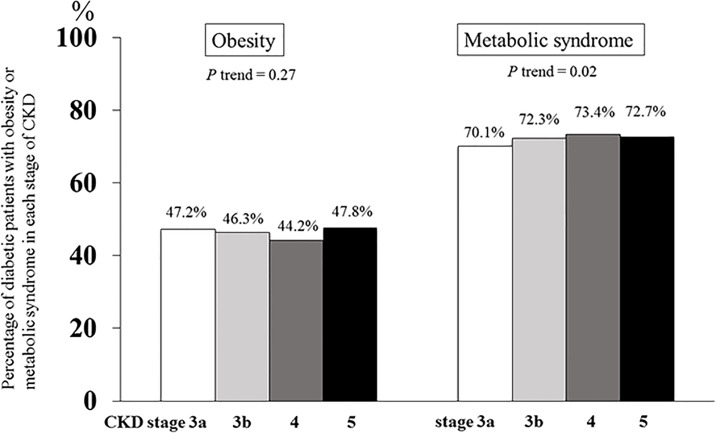
Percentage of type 2 diabetic patients with obesity and metabolic syndrome in each stage of chronic kidney disease (CKD).P trend <0.05 indicates statistical significance among CKD stage 3a, 3b, 4, and 5. White, light grey, dark grey, and black bars represent CKD stage 3a, 3b, 4, and 5, respectively.